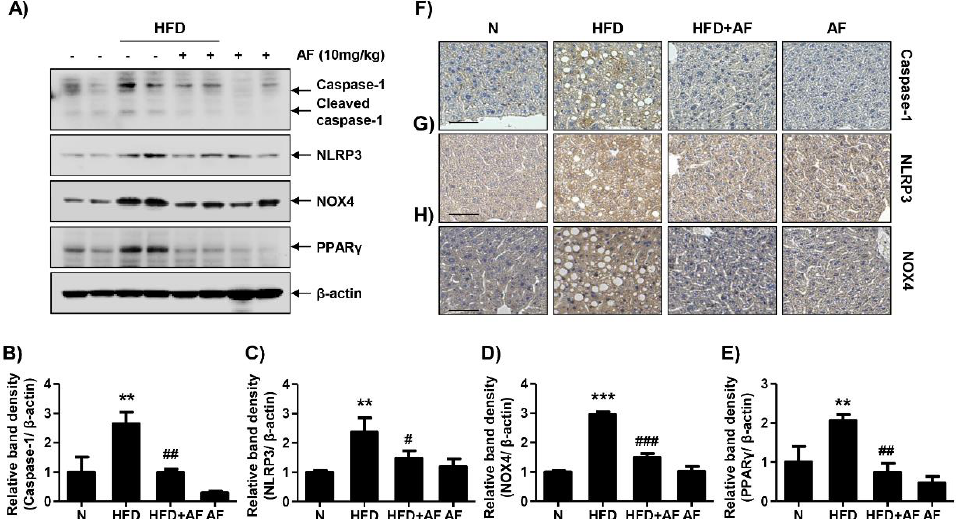
Figure 5. Auranofin reduces NOD-like receptor family pyrin domain containing 3 (NLRP3) inflammasome-associated proteins, NADPH oxidase 4 (NOX4) and peroxisome proliferator-activated receptor γ (PPARγ) expression in the liver of the HFD-induced NAFLD mouse model. ( A ) Western blots of caspase-1, NLRP3, NOX4 and PPARγ were performed with the liver tissue. ( B – E ) Quantification of activated caspase-1, NLRP3, NOX-4 and PPARγ. Data are expressed as means ± SD ( n = 4). ** p < 0.01 and *** p < 0.001 compared with the normal group. # p < 0.05, ## p < 0.01, and ### p < 0.001 compared with HFD group. ( F – H ) To evaluate the hepatic expression of caspase-1, NLRP3 and NOX4, paraffin blocks of liver were section into 4 μm thicknesses and stained with specific antibodies ( n = 3). Scale bar—50 μm. N, normal group; HFD, HFD fed group; HFD+AF, HFD fed and auranofin injection group; AF, auranofin injection group.